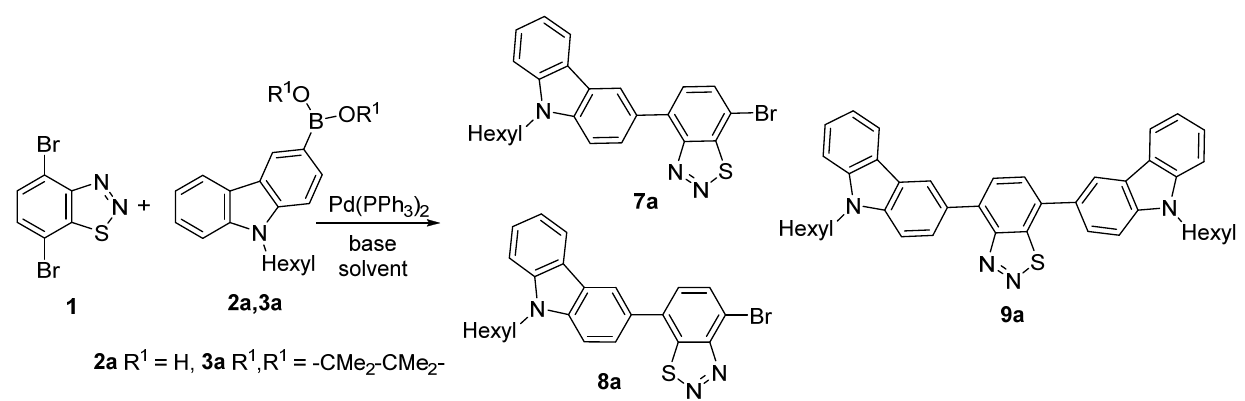
Scheme 1. Synthesis of KEA dyes 6 .